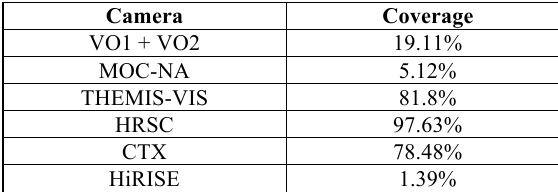
Table 1: Martian surface coverage for each orbiter camera. Duplicates are not included. Images with resolution coarser than 100 metres per pixel